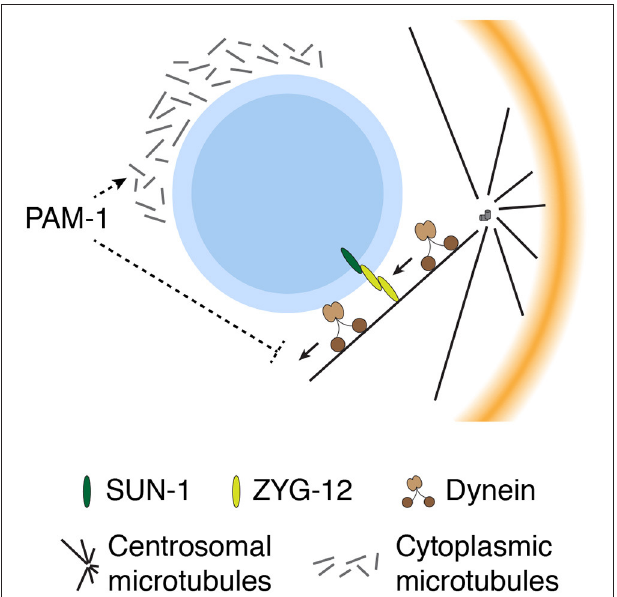
FIGURE 4 | Multiple mechanisms constrain movement of the pronucleus–centrosome complex near the cortex for efficient SB. Cytoplasmic microtubules prevent premature movement of the pronucleus–centrosome complex away from the cortex, whereas ZYG-12 physically links the centrosomes to the pronucleus. PAM-1 may contribute to the formation of cytoplasmic microtubules or suppress dynein-dependent movement of the pronucleus–centrosome complex prior to